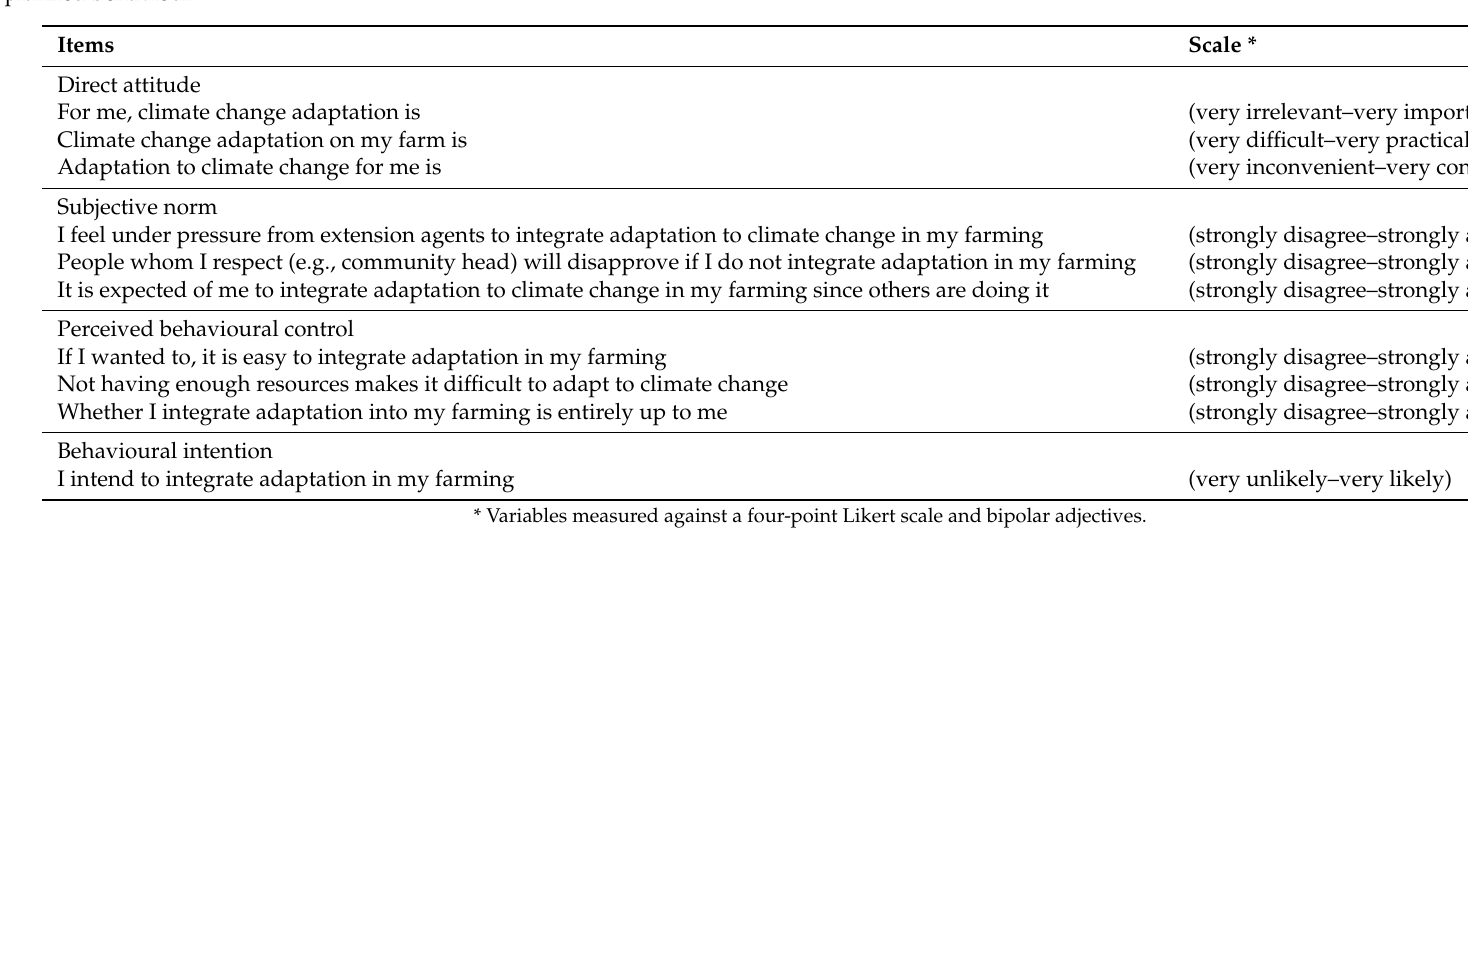
Table 1. Variables measured for attitude, subjective norm, perceived behavioural control and intention to adapt to climate change according to the theory of planned